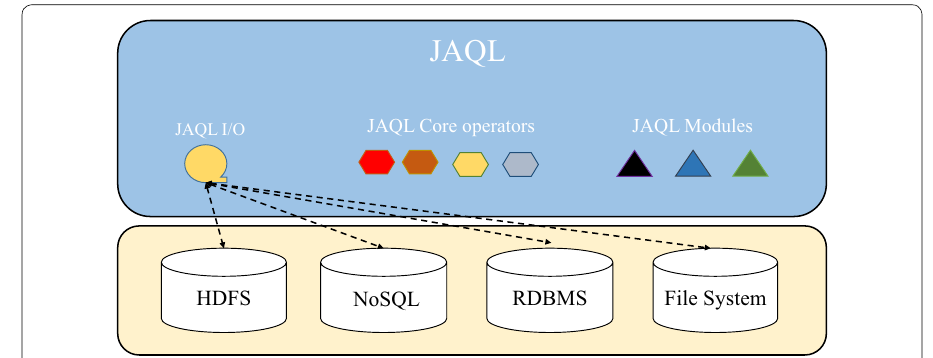
Fig. 3 The architecture system of